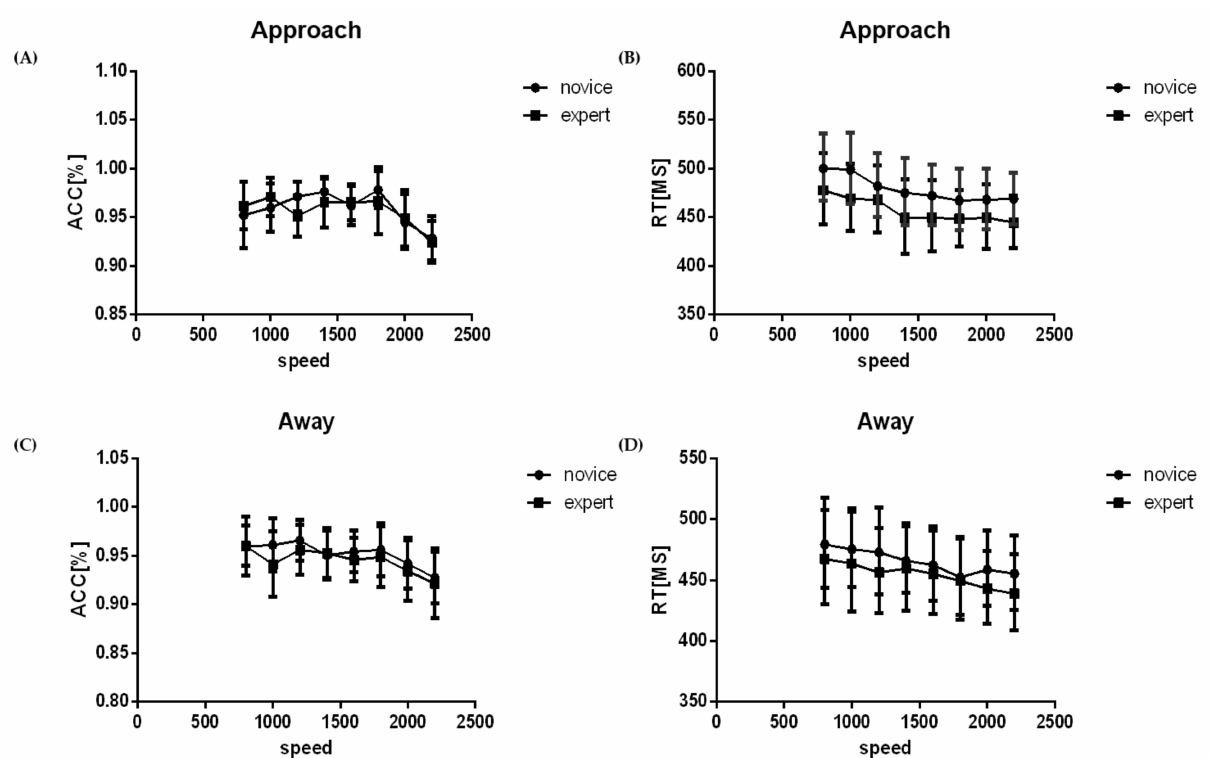
Figure 3. Reaction time and accuracy rate at different speeds. Average line chart of accuracy ( A ) and reaction time ( B ) of experts and novices when the sphere approached at different speeds. Average line chart of accuracy ( C ) and reaction time ( D ) of expert and novice when the sphere receded at different